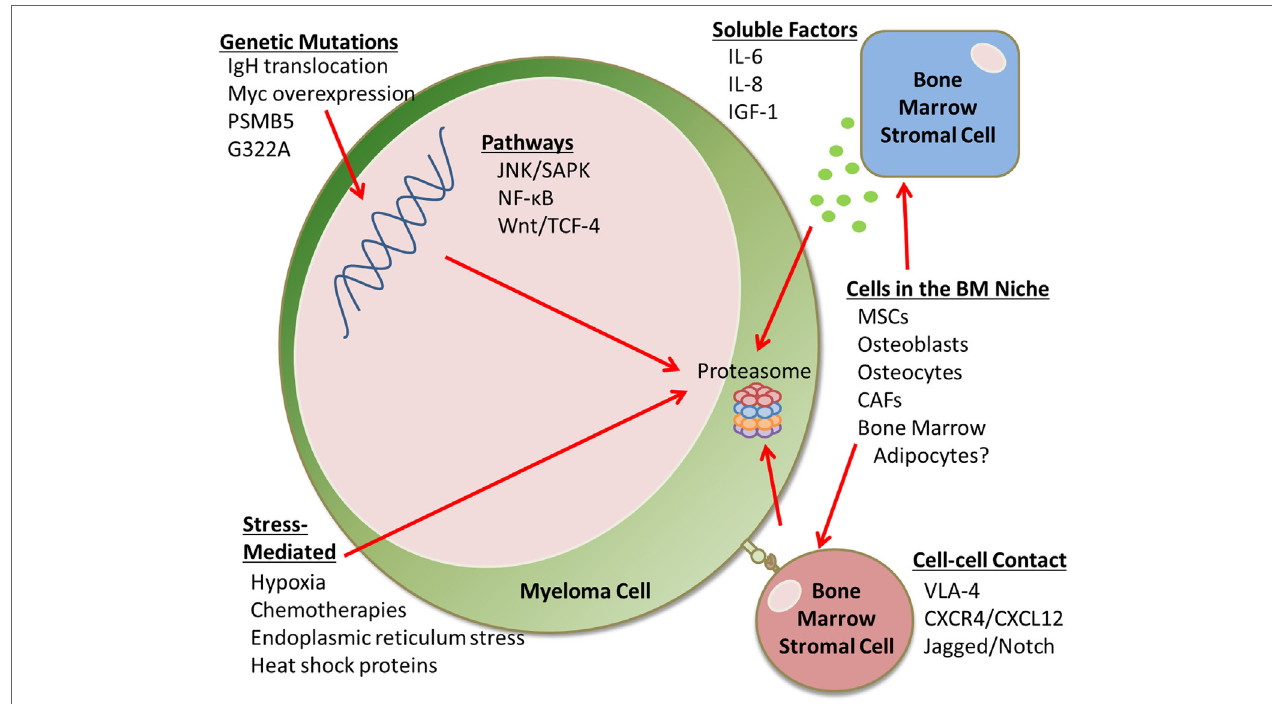
FiguRe 1 | Proteasome inhibition resistance mechanisms. This mini-review discusses the many factors that contribute to proteasome inhibitor (PI) resistance in the bone marrow (BM). For example, there are genetic mutations that can lead to drug resistance, as well as soluble factors and cell–cell contact-mediated signals from an array of BM stromal cells that can cause PI resistance. Cells that can cause drug resistance include mesenchymal stem cells (MSCs), osteoblasts, osteocytes, cancer-associated fibroblasts (CAFs), and potentially BM adipocytes. Stress-mediated responses can also cause PI resistance.